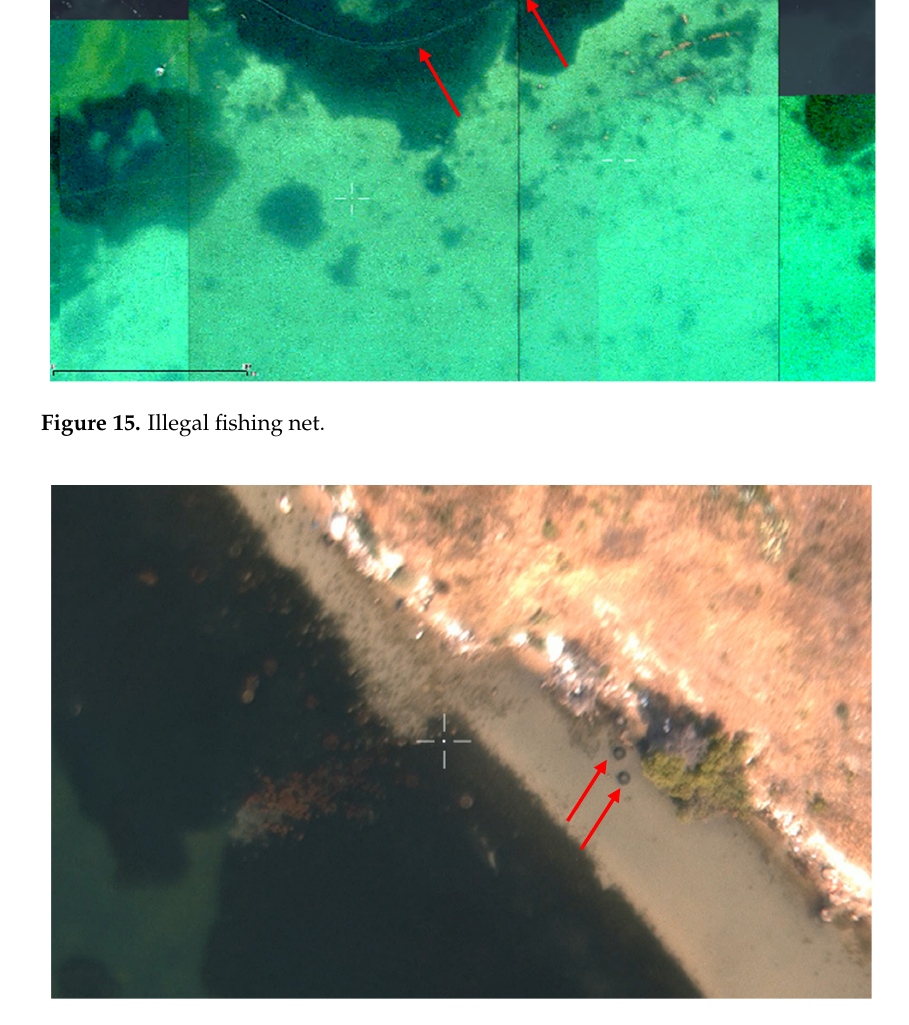
Figure 16. Detail of two tires (red arrows) on the beach.